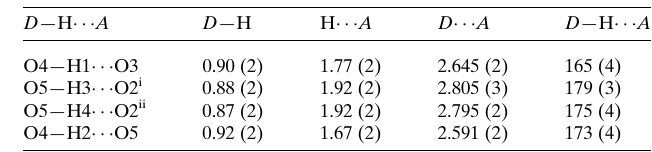
Table 1 Hydrogen-bond geometry (A˚ , (cid:3) ).